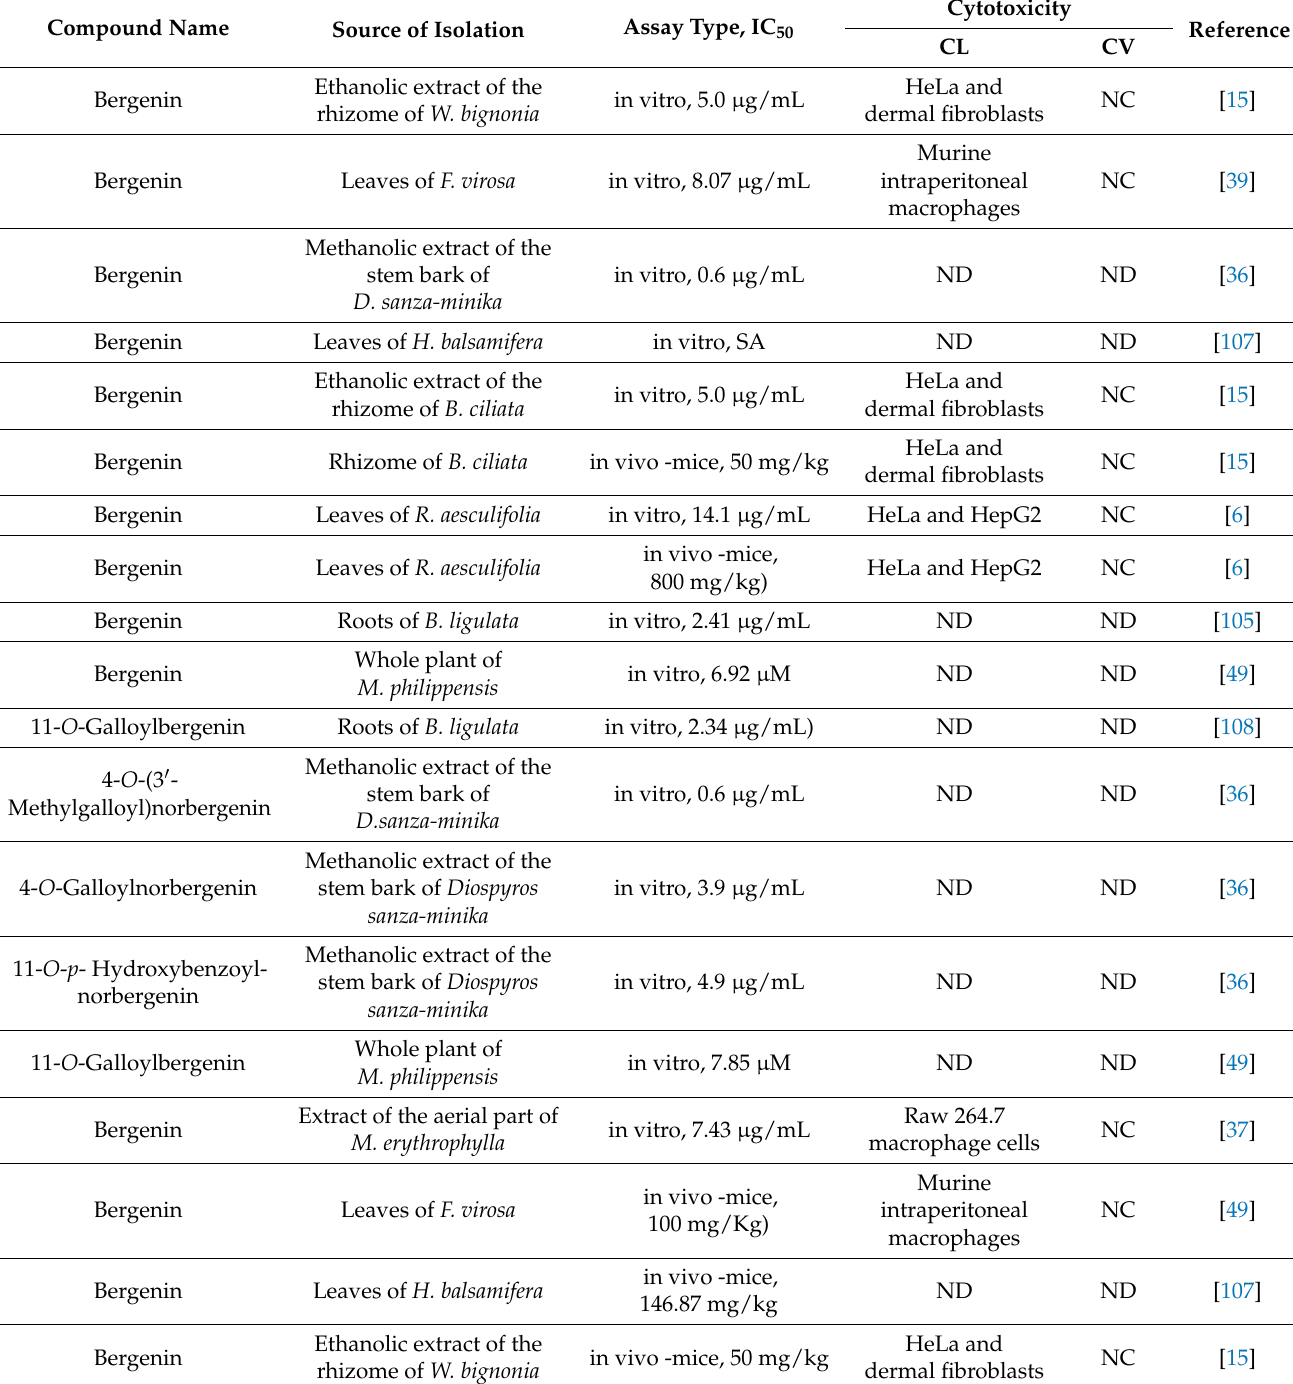
Table 2. Summary of studies regarding the antimalarial activity of bergenin and its